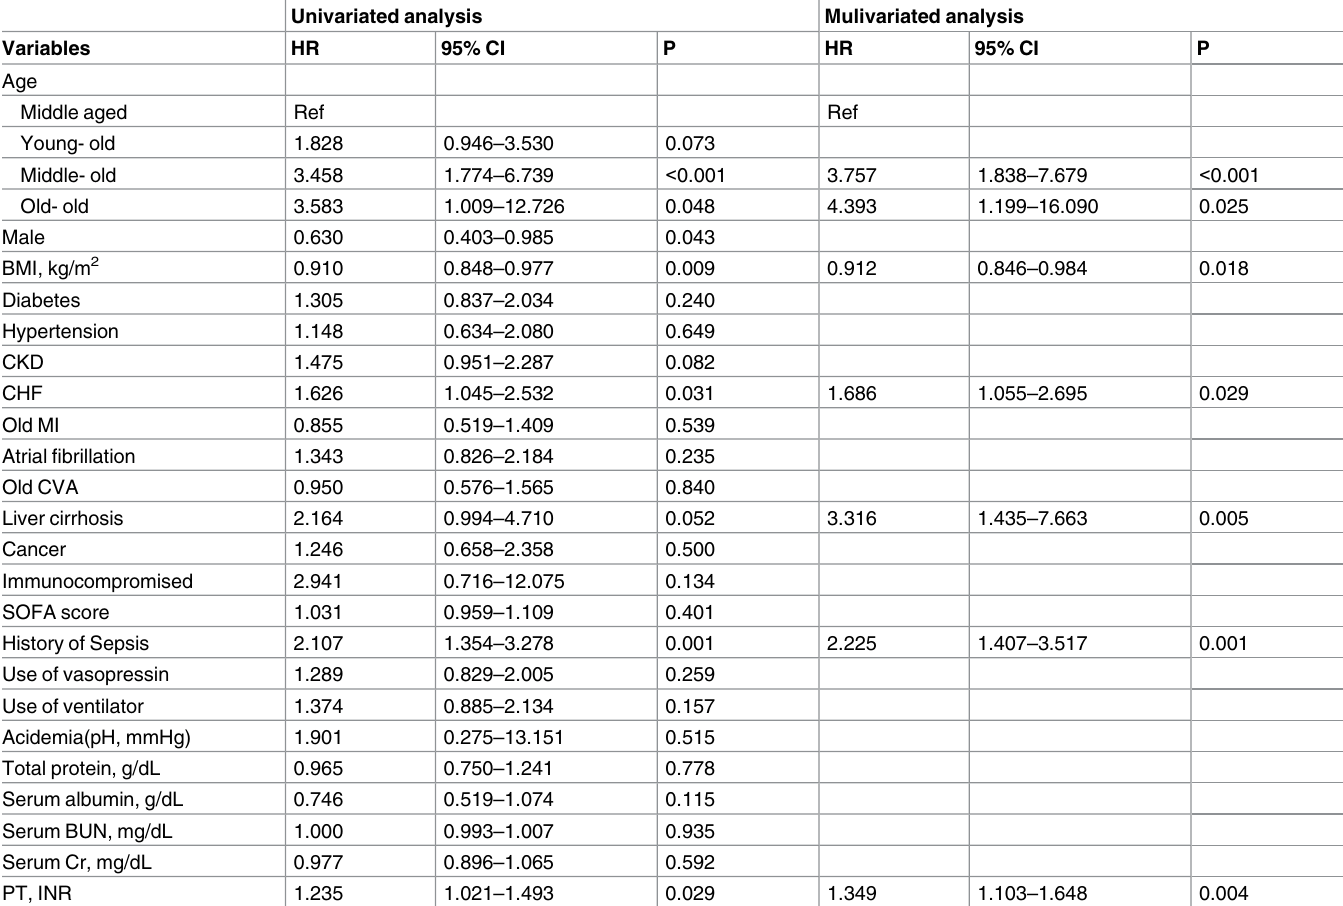
Table 4. Factors associated with longterm